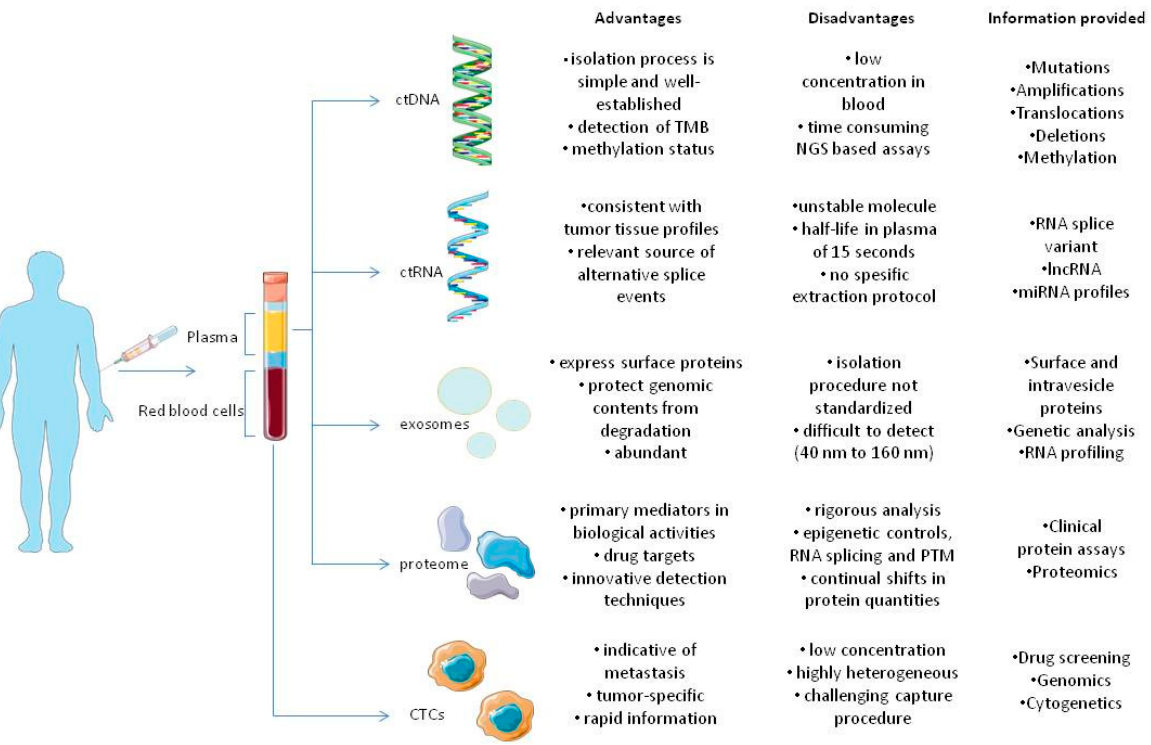
Figure 1. Components of tumor circulome examined in liquid biopsies and their applications . The several analytes extracted from blood provide a wide variety of information regarding tumors. As previously stated, all analytes share different advantages and disadvantages that favor or oppose their usage in clinical settings, in tumor diagnosis, monitoring and therapy [23].